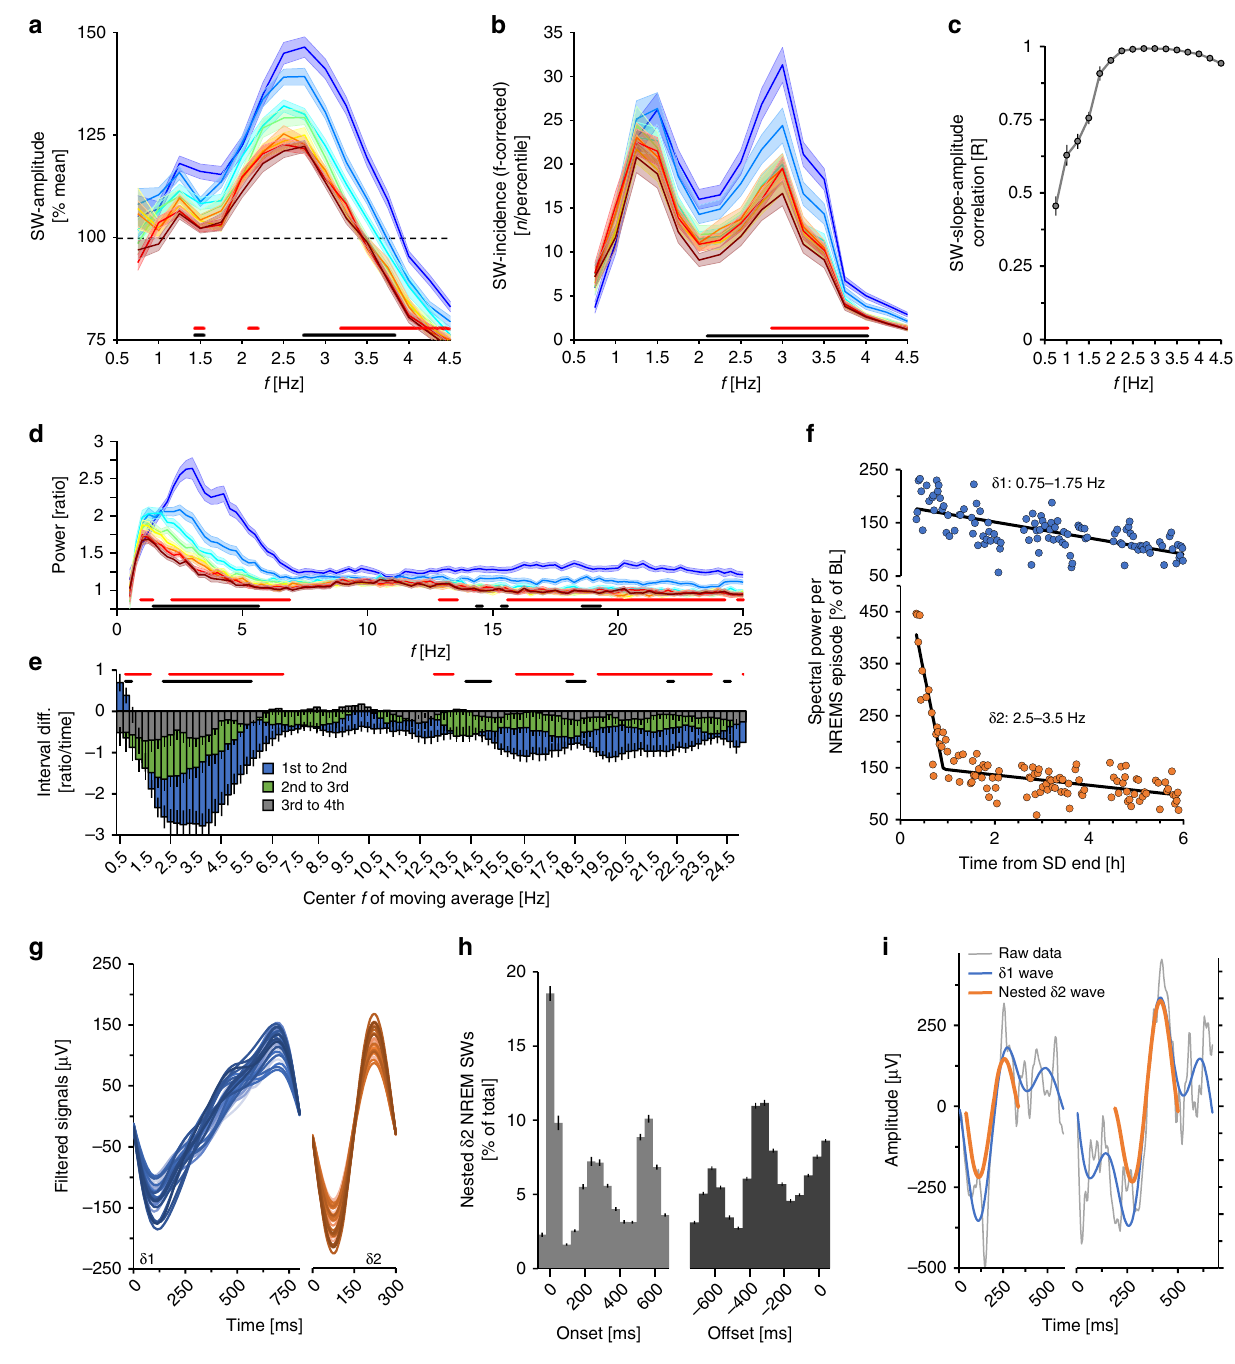
(Supplementary Fig. 4a), the fraction of nested δ 2-waves out of all δ 2-waves was low immediately after prolonged waking periods (Supplementary Fig. 5c). δ 2-power, but not δ 1-power re fl ects prior sleep-wake history . Given the radical differences in the two δ -bands immediately following SD, we probed their dynamics under various condi- tions. At wake-to-NREMS transitions immediately at recovery onset (i.e., in the 1st of the 25 NREMS quantiles; 8.9 ± 0.5 min NREMS), δ 2-power increased more rapidly compared to δ 1, reaching maximum levels around 32 s (Fig. 3a). Rise-to- maximum regressions indicated a >5-fold faster buildup for δ